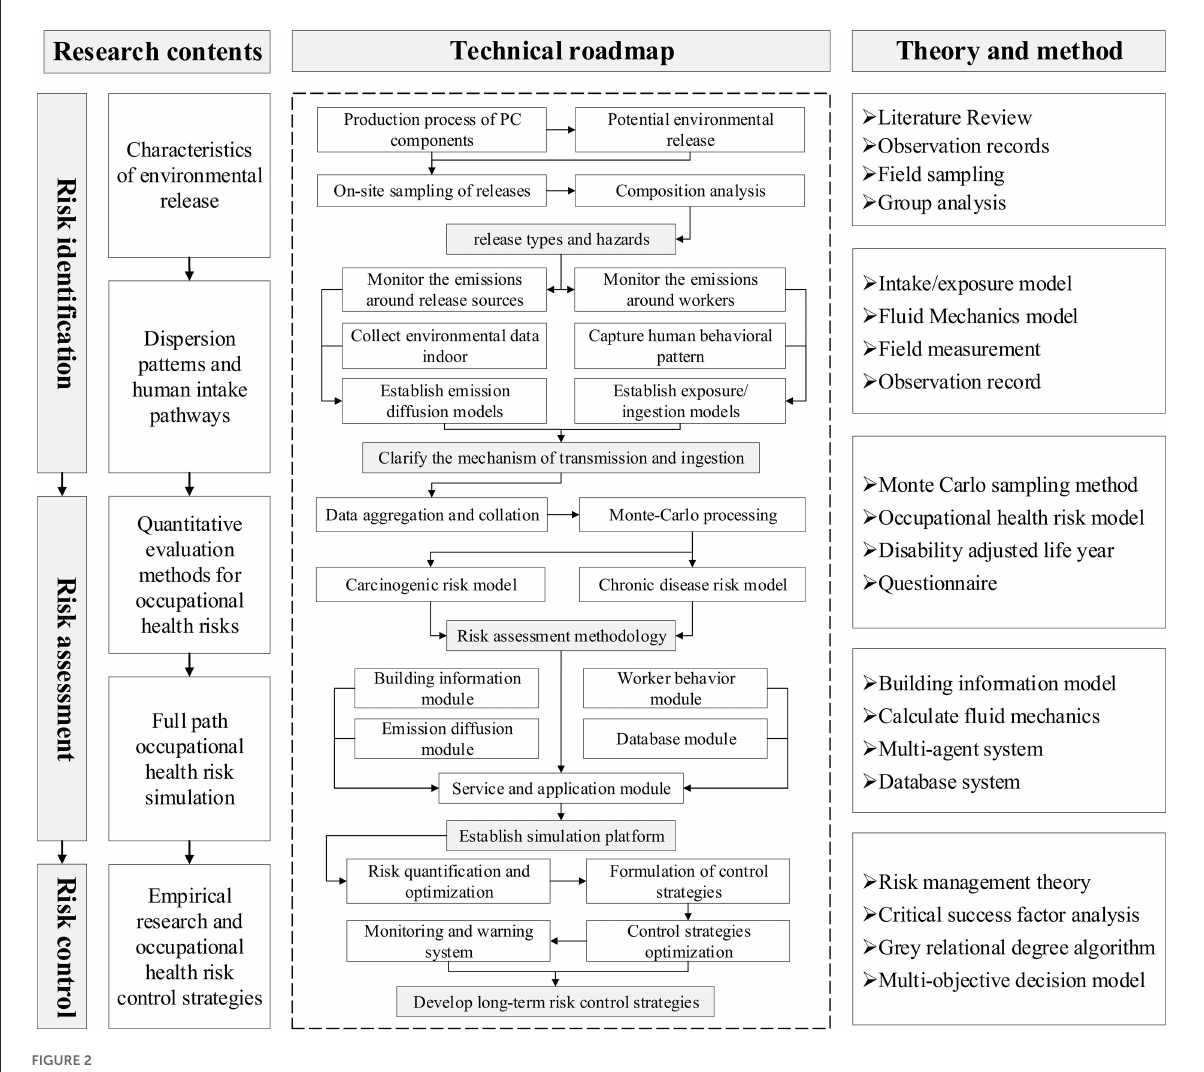
FIGURE2 Occupational health risk